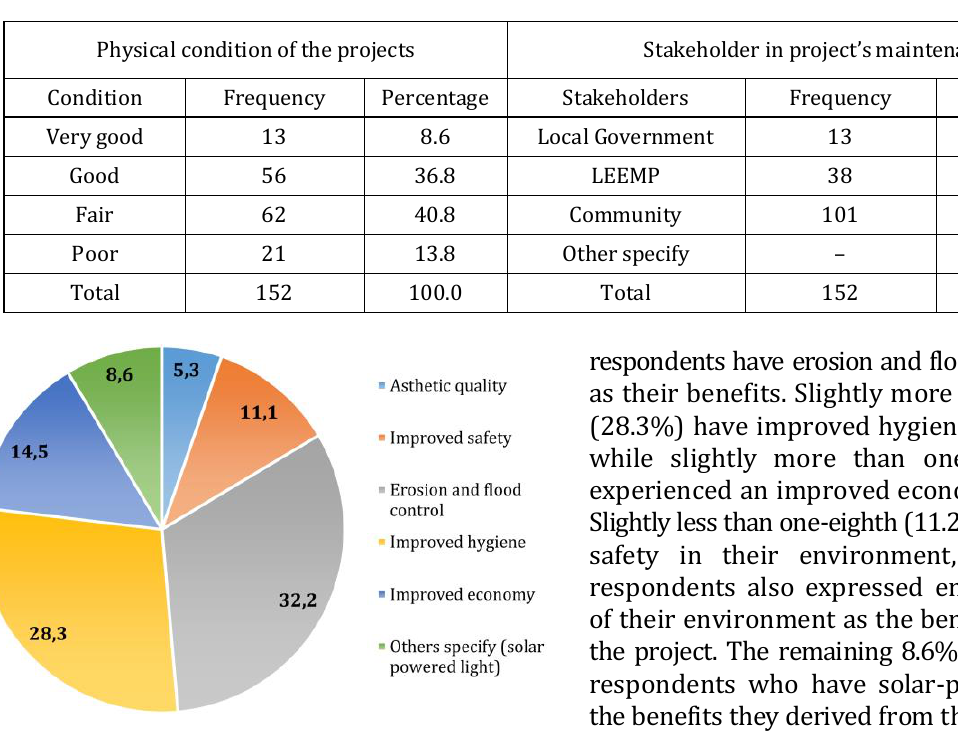
Table 4. Existing physical conditions of the projects